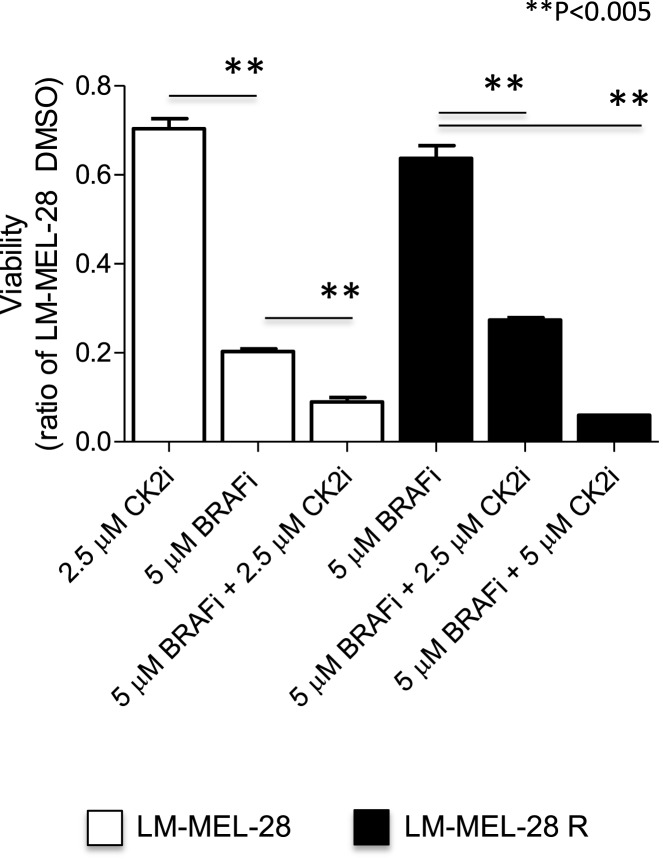
CK2i of the drug resistant cell line (LM-MEL-28-R1). The effects of co-inhibition with the CK2 inhibitor CX-4945 and BRAFi (PLX4072) on proliferation of the drug resistant cell population LM-MEL-28-R1 were quantitated by viability assay, analyzed using a Student’s t-test (error bars are SD).